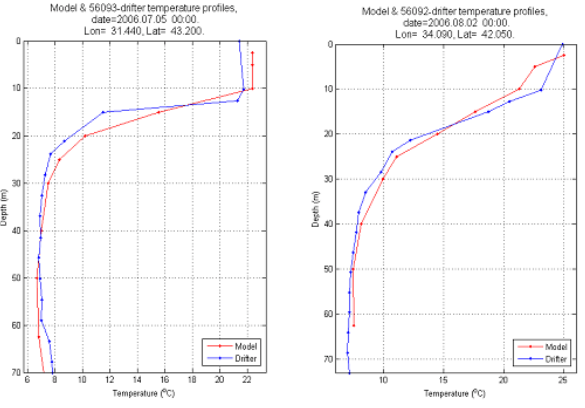
Figure 9 Bias (blue line), standard deviation (red line) and correlation coefficient between SST retrieved from AVHRR data and simulated by the model as function of time.